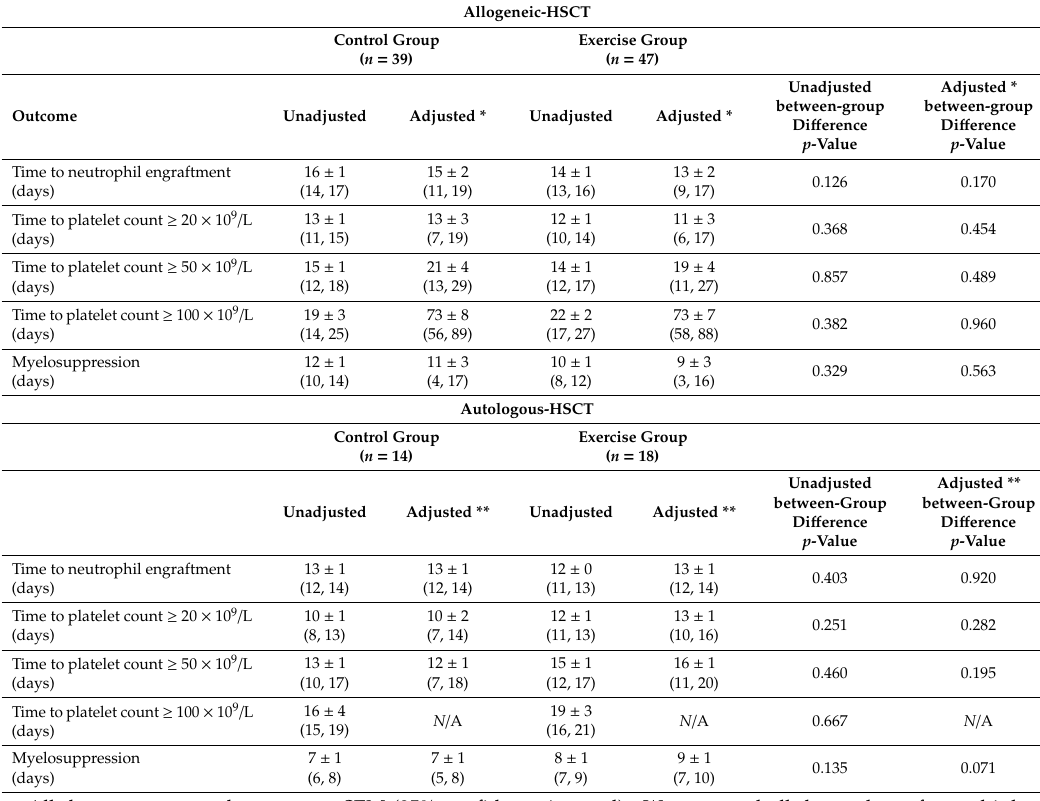
Table 3. E ff ects of exercise intervention on secondary outcomes (engraftment